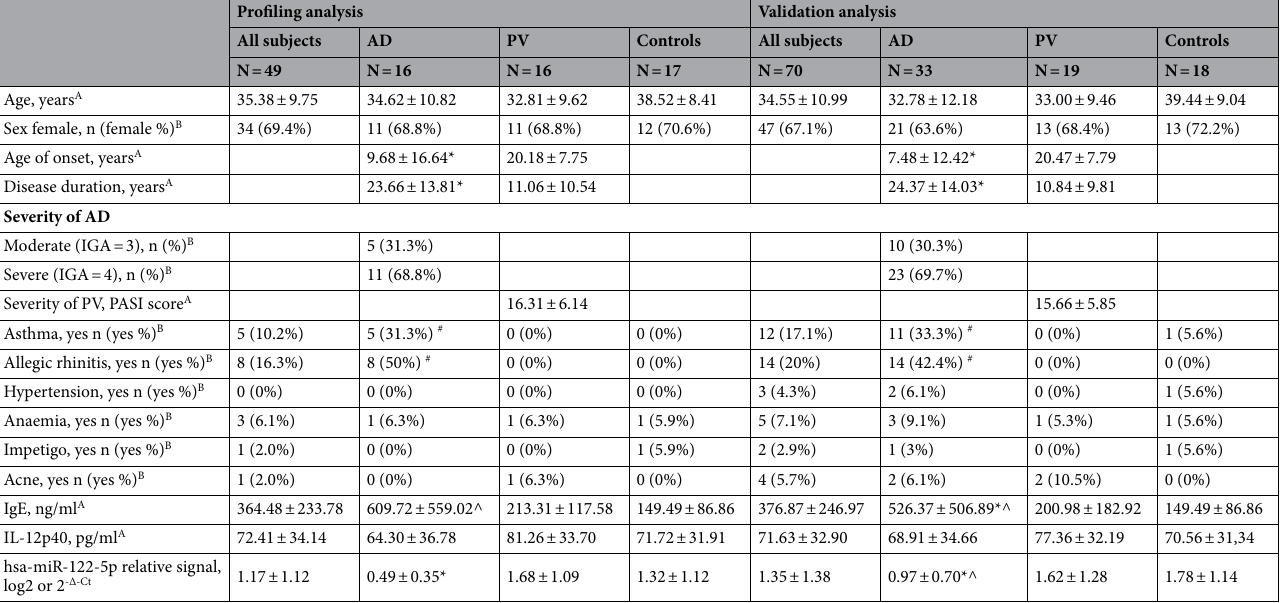
Table 2. Characteristics of recruited AD and PV patients and age matched controls for the study of serum samples. AD atopic dermatitis, PV psoriasis vulgaris, IGA investigator’s global assessment score for overall severity of AD signs, PASI psoriasis area severity index for overall severity of psoriasis signs. A Data are shown as mean ± standard deviation (SD). ANOVA (post hoc test) *p ˂ 0.05 comparing AD vs PV, ^ p ˂ 0.05 comparing AD vs controls. B Data are shown as absolute numbers and percentages in brackets. Chi Square test, # p ˂